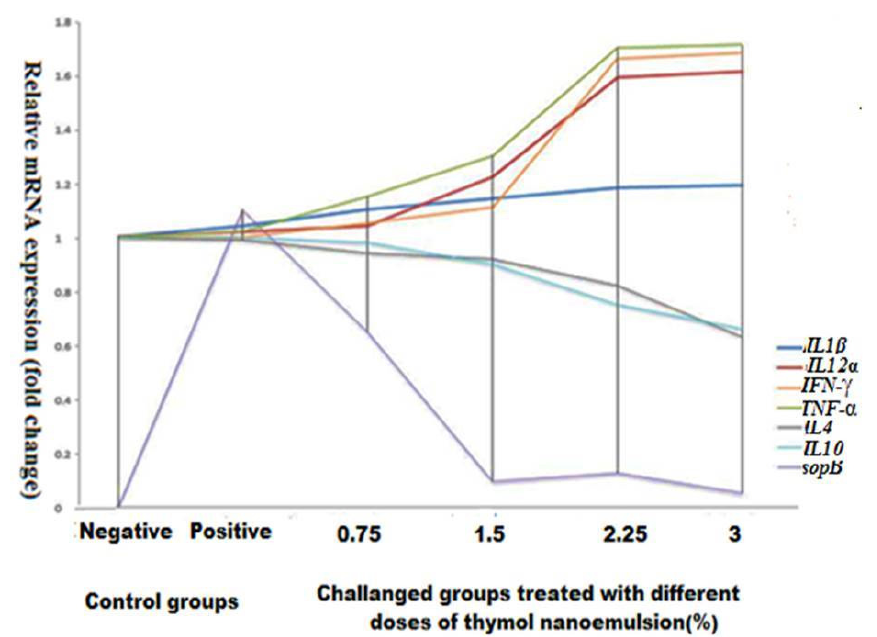
Figure 4. Expression of cytokines and sopB genes in the splenic and cecal samples of S. Enteritidis challenged broilers in response to treatment with 0.75, 1.5, 2.25, and 3% thymol nanoemulsion, respectively.